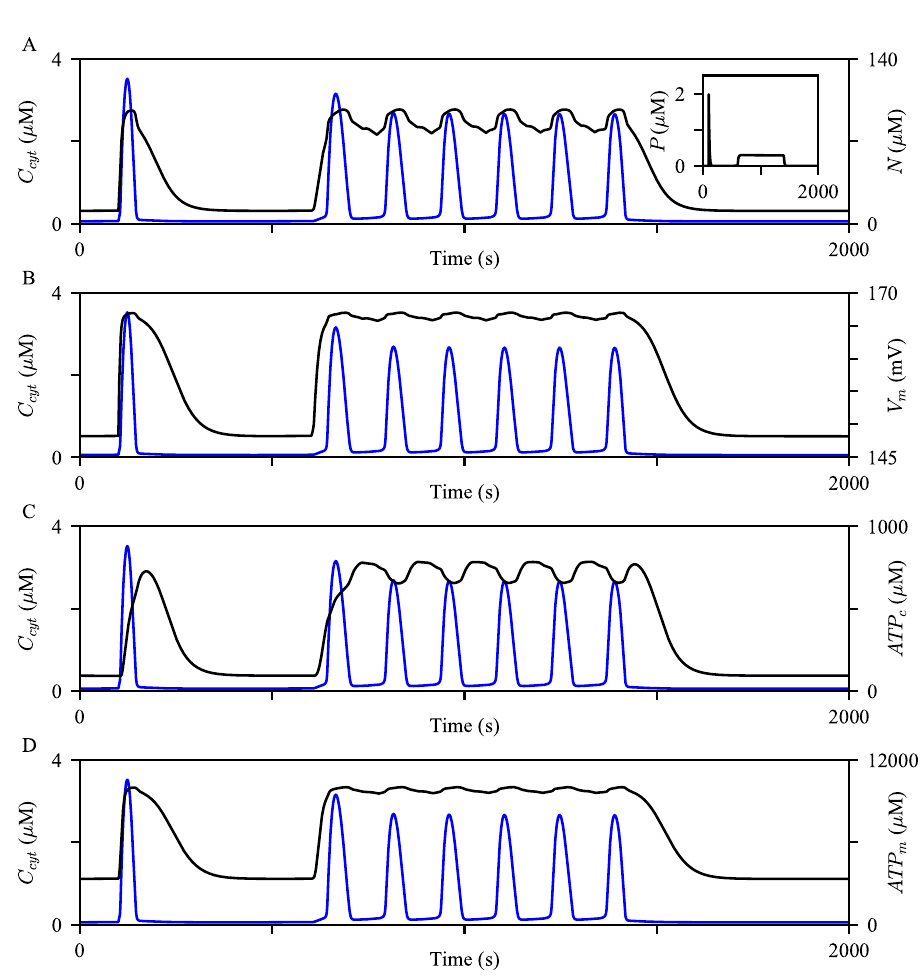
Fig 3. Evolution of mitochondrial variables. The model was simulated with two different styles of IP 3 dynamics, are shown by the blue curves. The black curves show shown by the inset graph of (A). The resulting behaviors of C cyt (A) V m , (B) N , (C) ATP c , and (D) ATP m timeseries concurrent with the C cyt